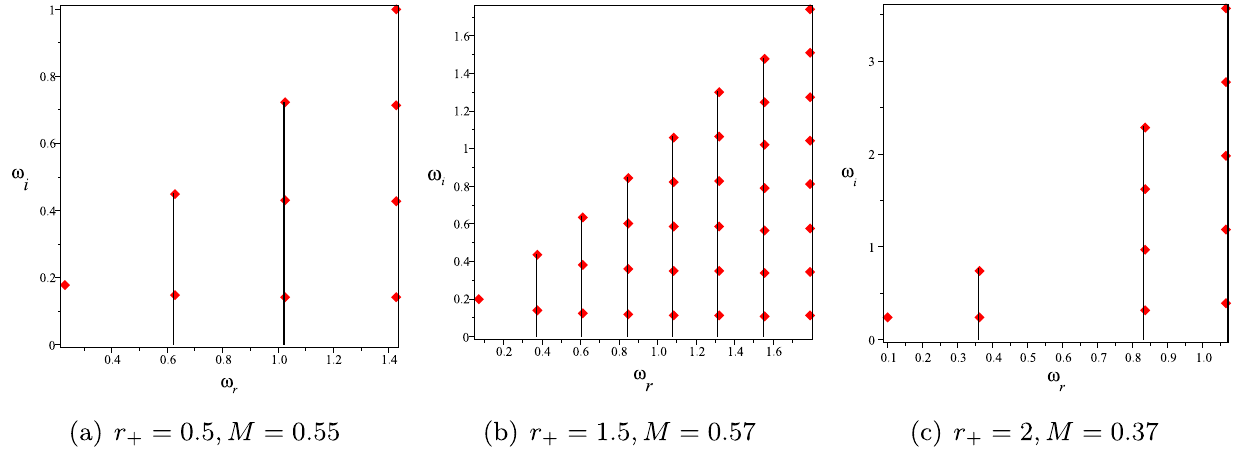
Fig. 5 The behavior of ω i in terms of ω r for j = 0 , 1 , 3 , 4 (left) and j = 0 , 1 , 2 , 3 , 4 , 5 , 6 , 7